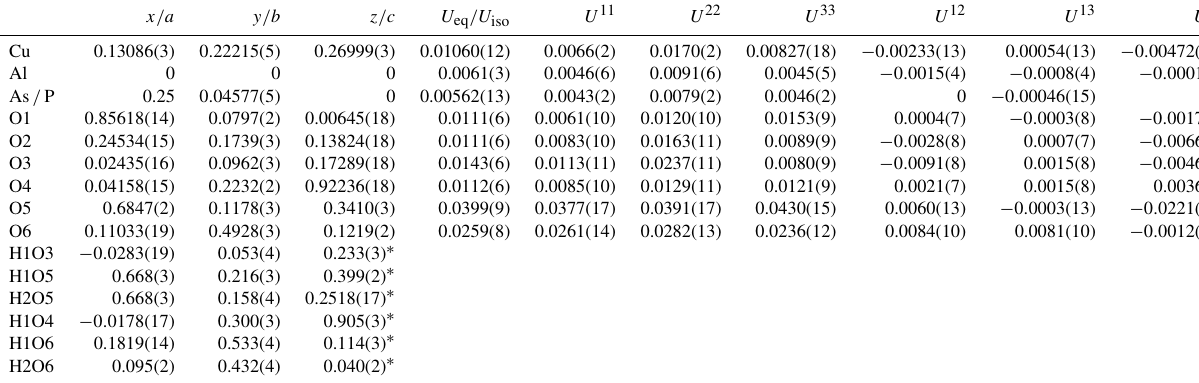
Table 3. Atom coordinates and equivalent and anisotropic displacement parameters for liroconite.